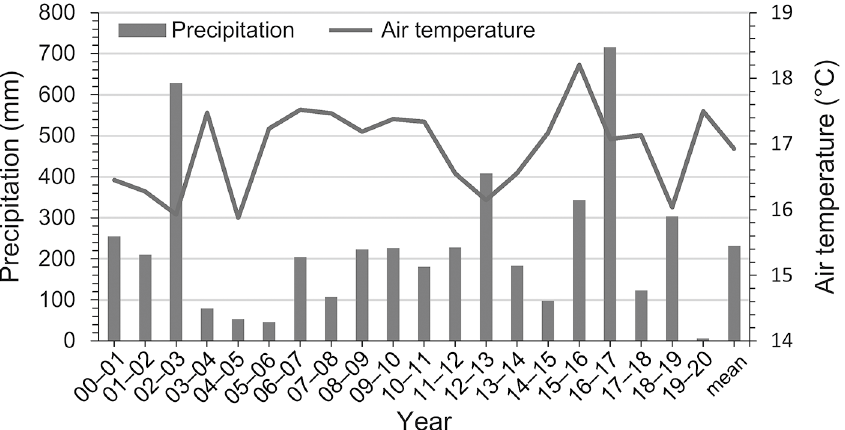
Figure 10. Total precipitation and mean air temperature during dry season over the last 20 years. The grey bar and line on the farmost right side represent 20-years of mean precipitation and temperature for the dry season, respectively. The study period of this study is 2019–2020 (i.e., 19–20), in which precipitation is extremely low.